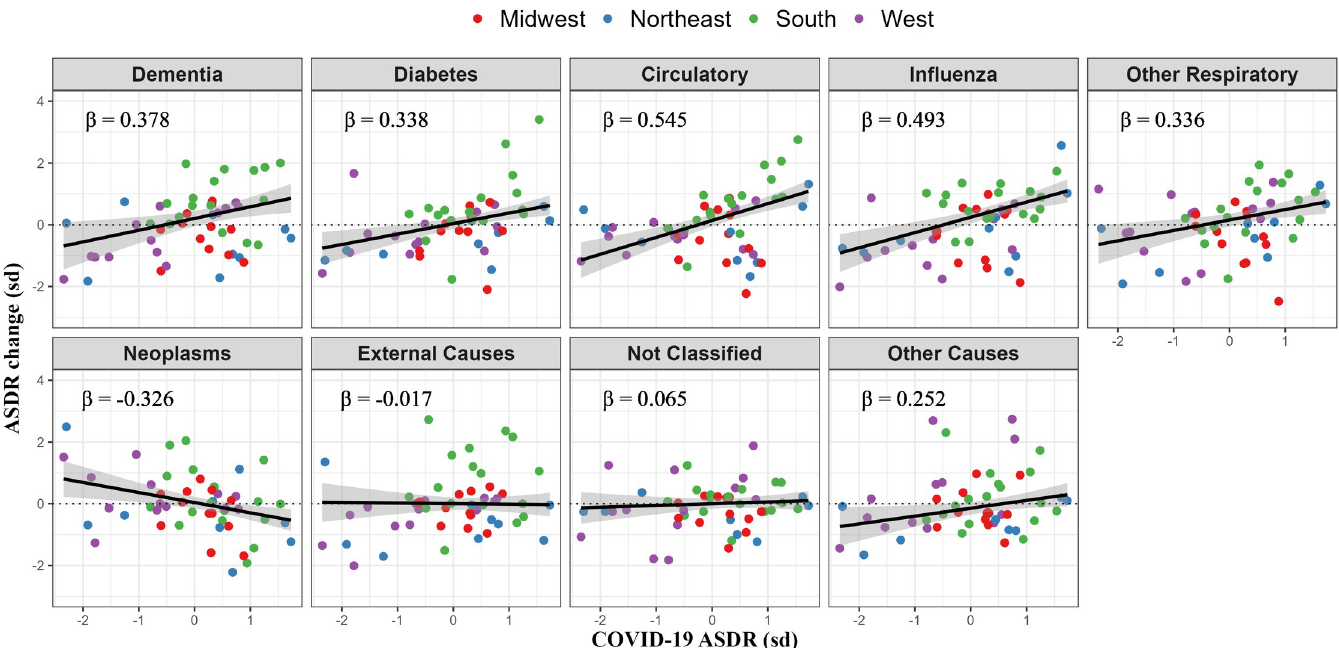
Fig 3. Standardized association between state-level COVID-19 mortality and change in cause-specific mortality, ages 25+. Note: ASDR = age-standardized death rates. Change is measured as the age-standardized death rate in first full year of the pandemic (March 2020 to February 2021) relative to the same period a year prior (March 2019 to February 2020), with coefficients standardized (mean = 0 and standard deviation = 1). Line reflects weighted linear regression where weights are the corresponding size of population in state i. Points above the dotted line indicates states with increases in cause-specific age ASDR, while below indicates decreases. β represents the change in ASDR for a particular cause of death in SD units associated with a 1 SD unit increase in COVID-19